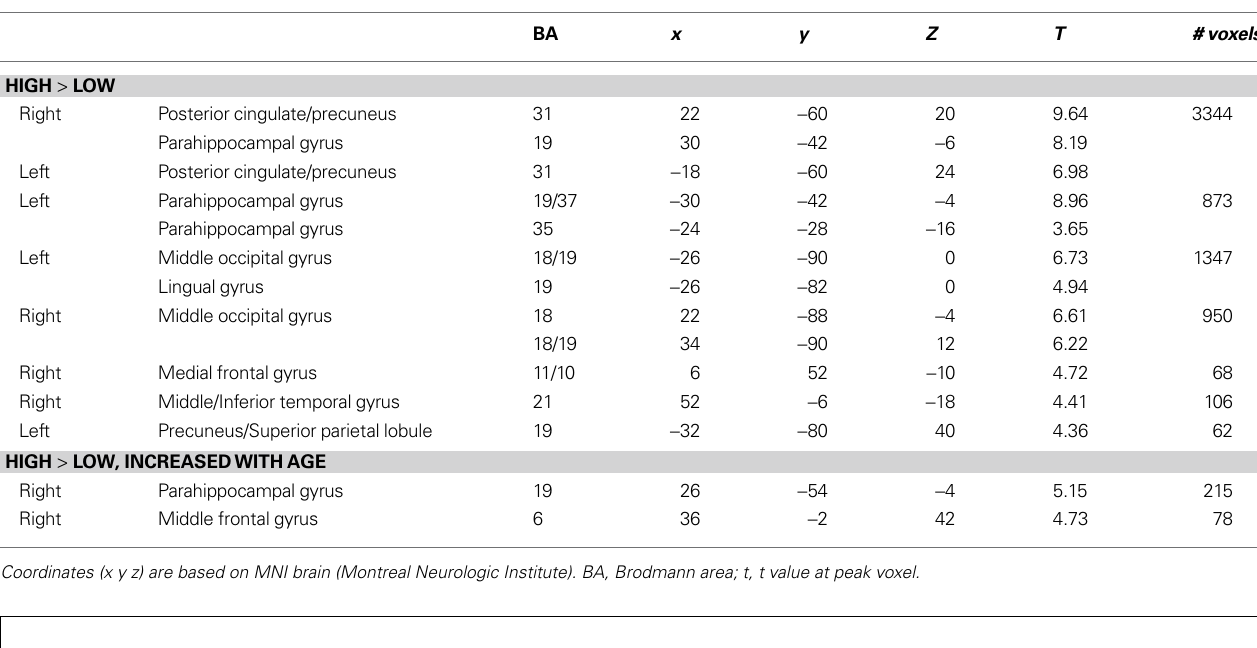
Table 1 | Activations for high- versus low-complexity scenes.